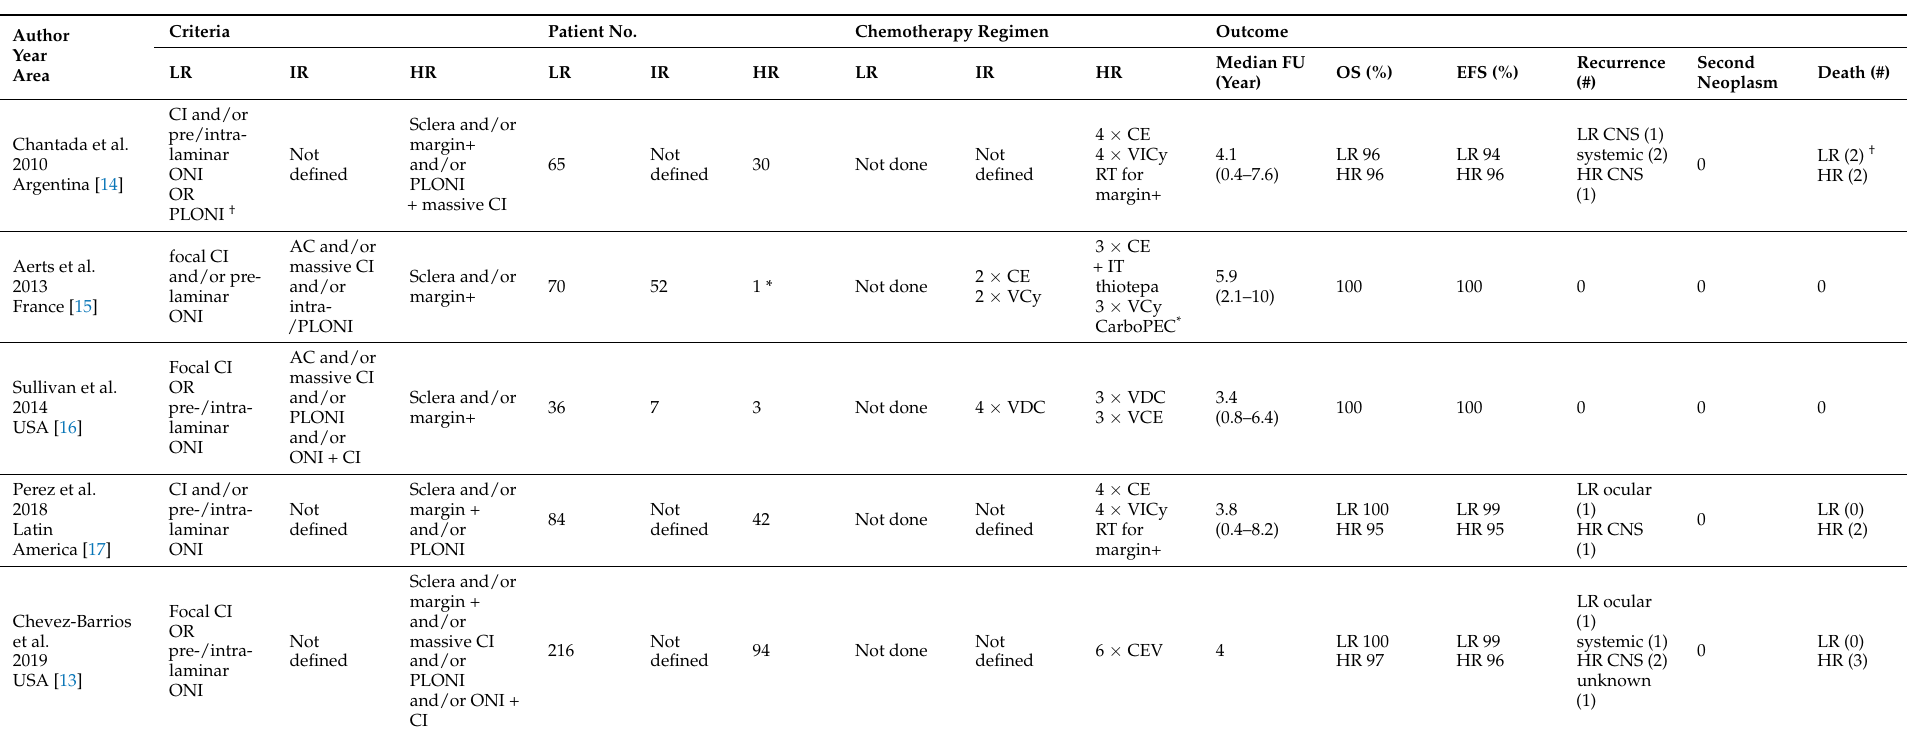
Table 3. Summary of prospective studies on post-enucleation chemotherapy of unilateral high-risk